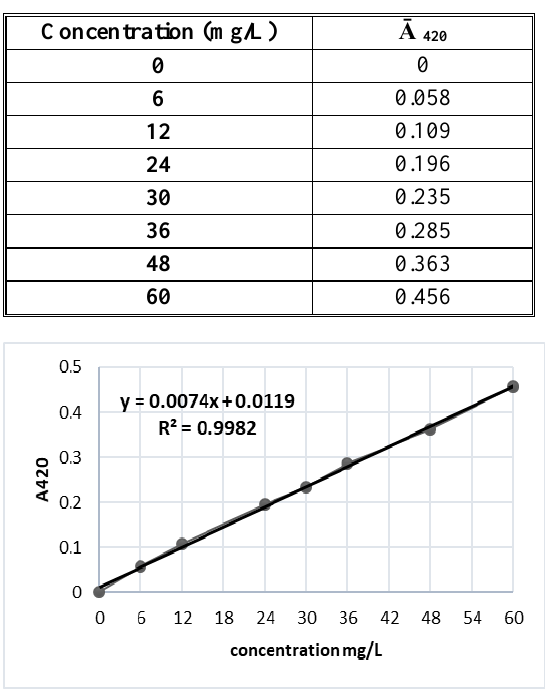
Figure 5. Quercetin calibration curve TFC of the extracts Flavonoids content in the extracts is also presented in Table (4) . As the methanolic extract showed the highest phenolic amount, it contained the highest flavonoid content (38.9 mg QE/ g DE), followed by MeOH: EtOAc (1:1), EtOH 50%, distilled H 2 O and CHCl 3 extracts, respectively. The TFC results are shown in Figure (6) .